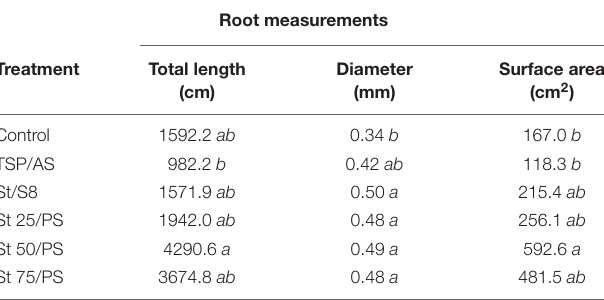
TABLE 1 | Effect of treatment on average total root length, root diameter, and surface